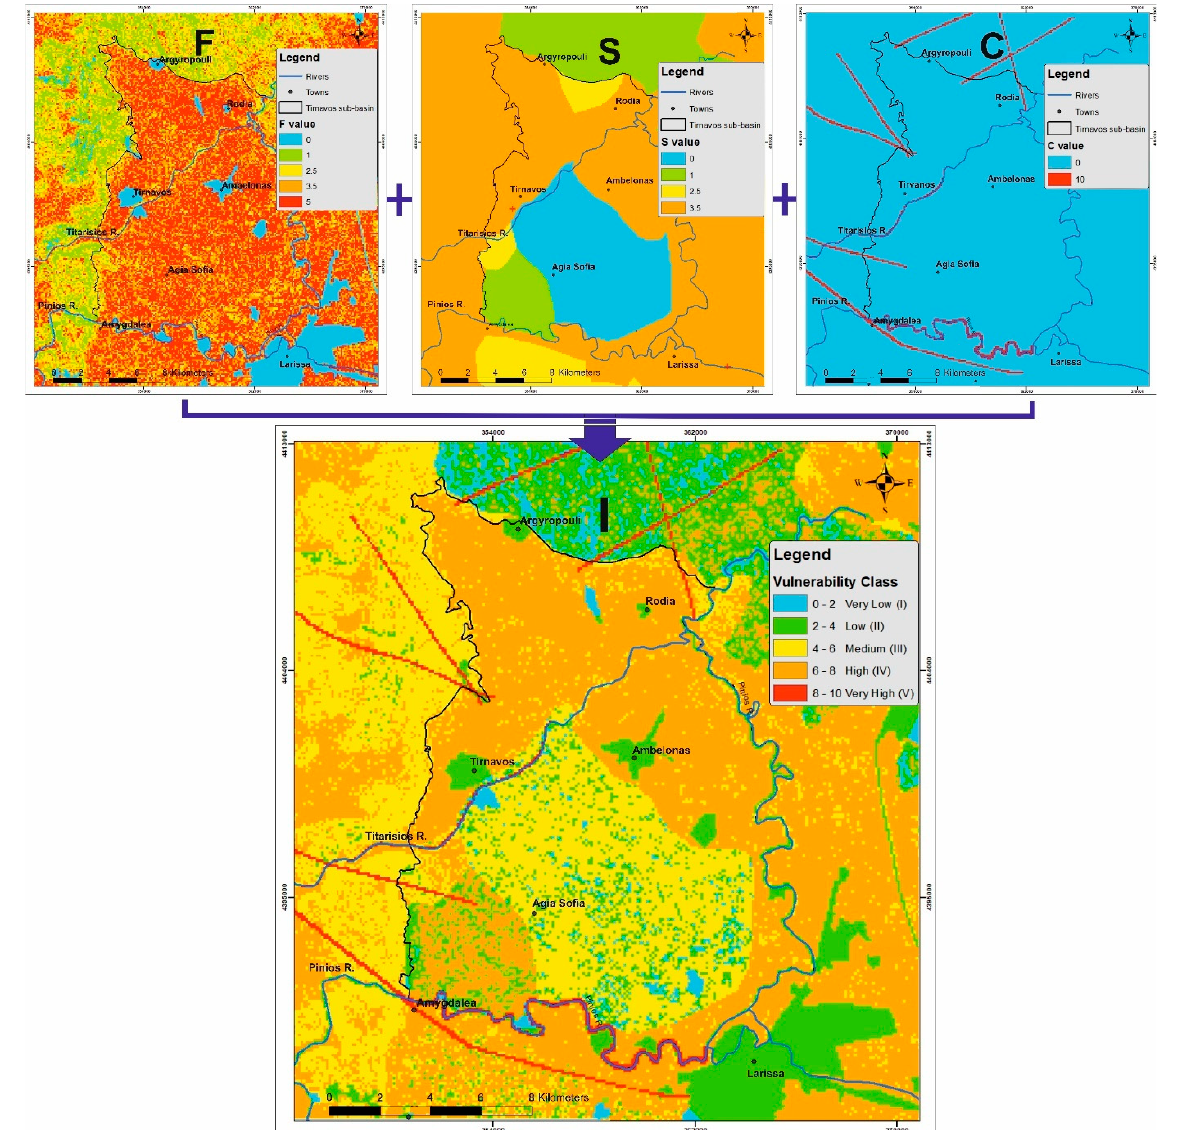
Figure 6. Spatial distribution maps of F, S, and C sub-factors in the Tirnavos basin. According to the I factor, the final map of vulnerability classes results from the composition of the three above mentioned thematic maps.